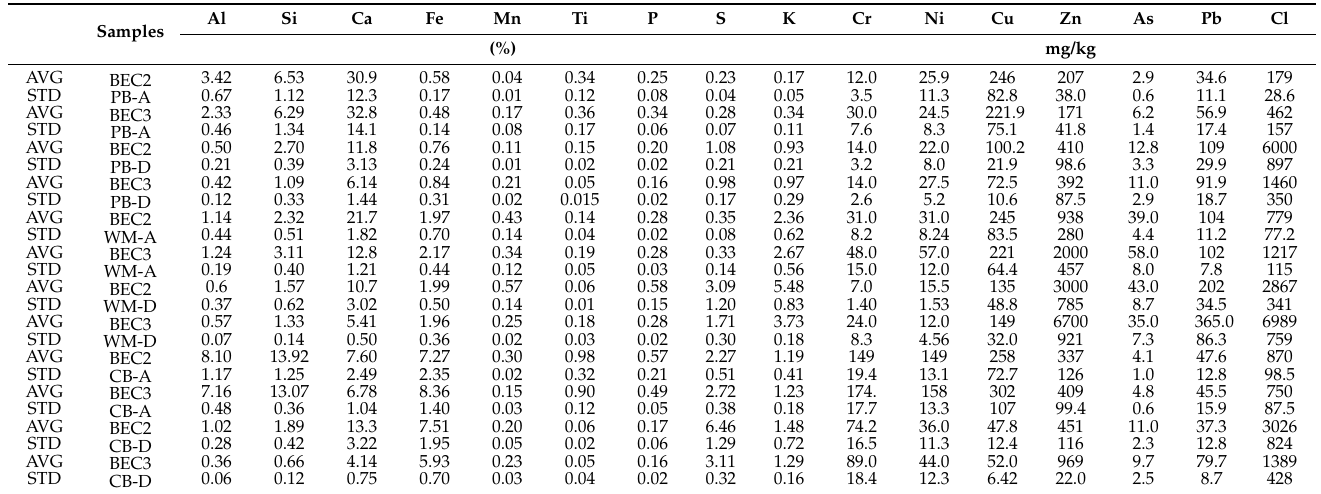
Table 7. Concentration of major and trace elements in ash and deposit (arithmetic mean and standard deviation). Samples